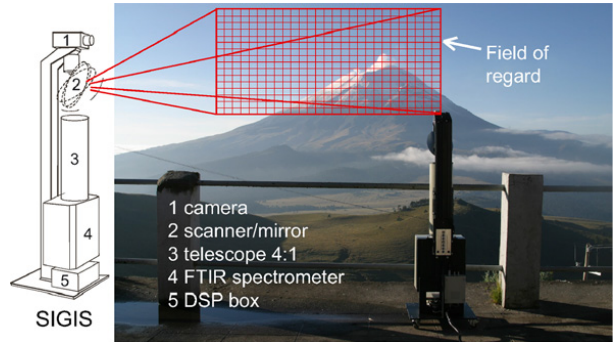
Fig. 2. (a) Schematics of the SIGIS construction with correspond- ing components and (b) illustration of the instrument scanning a 2-D image represented by the field of regard (red